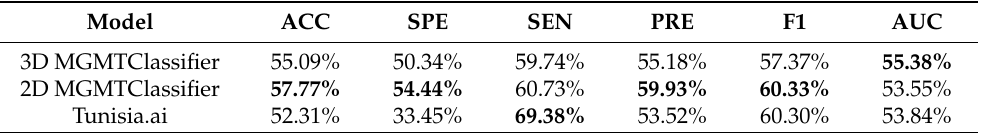
Table 1. 5-fold CV performances of models trained and tested on dataset A . The input sequence is KBF for both the 3D and 2D MGMTClassifier models and T1-w CE for the Tunisia.ai one. For each metric, the best value is reported in